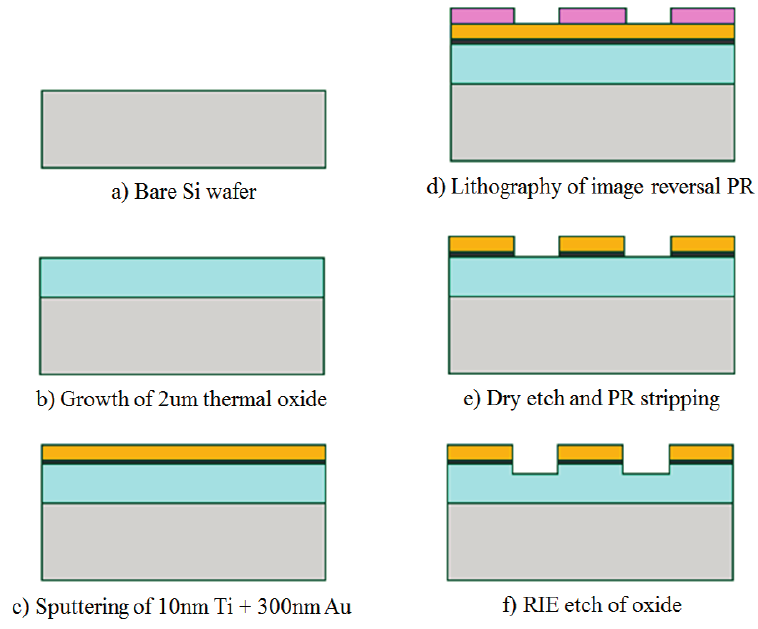
Figure 1. Interdigitated electrodes (IDEs) fabrication process.